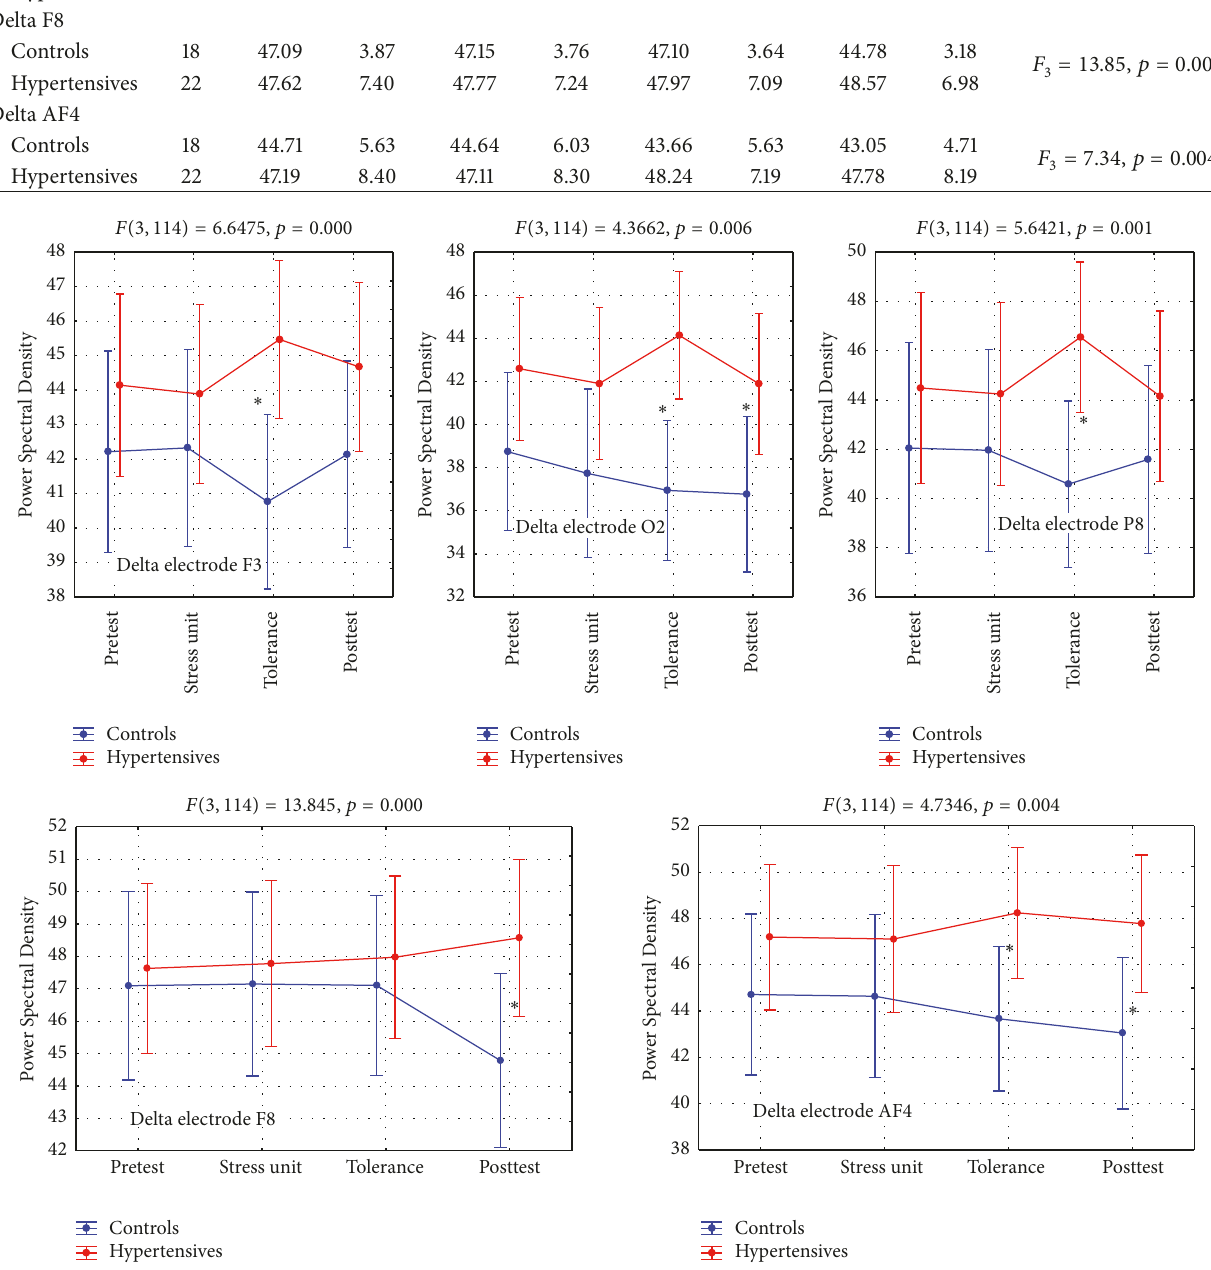
Figure 1: Delta brain activity (DBA). ∗ refers to statistically significant